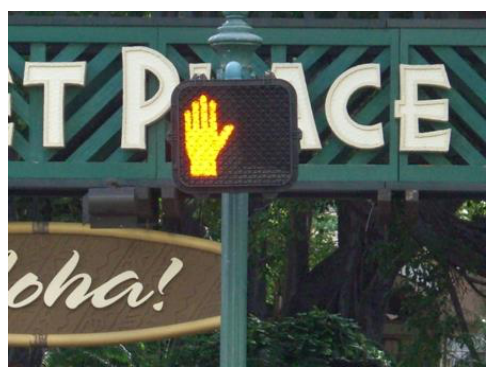
Figure 22. Road stop sign,